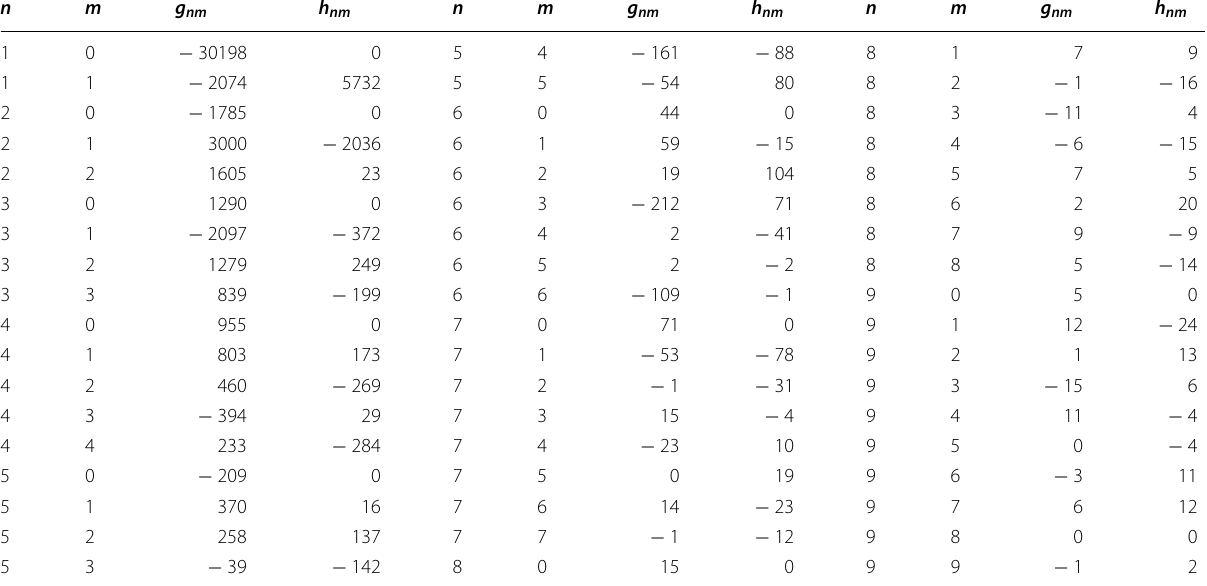
Table 3 Gauss coefficients of the new geomagnetic field model based on the measurements from the Kosmos-321 satellite (N-2); the coefficients are listed in three